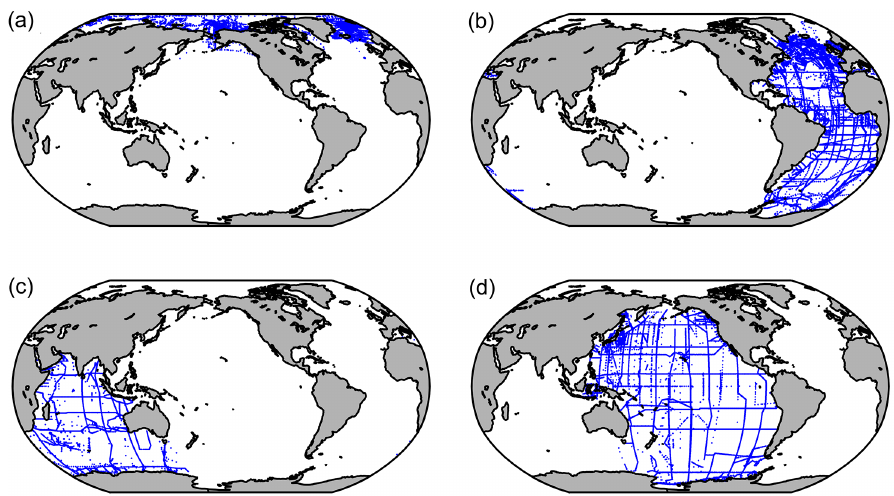
Figure 7. Locations of data included in the (a) Arctic, (b) Atlantic, (c) Indian, and (d) Pacific ocean product files. Note the minor “spillover” near the